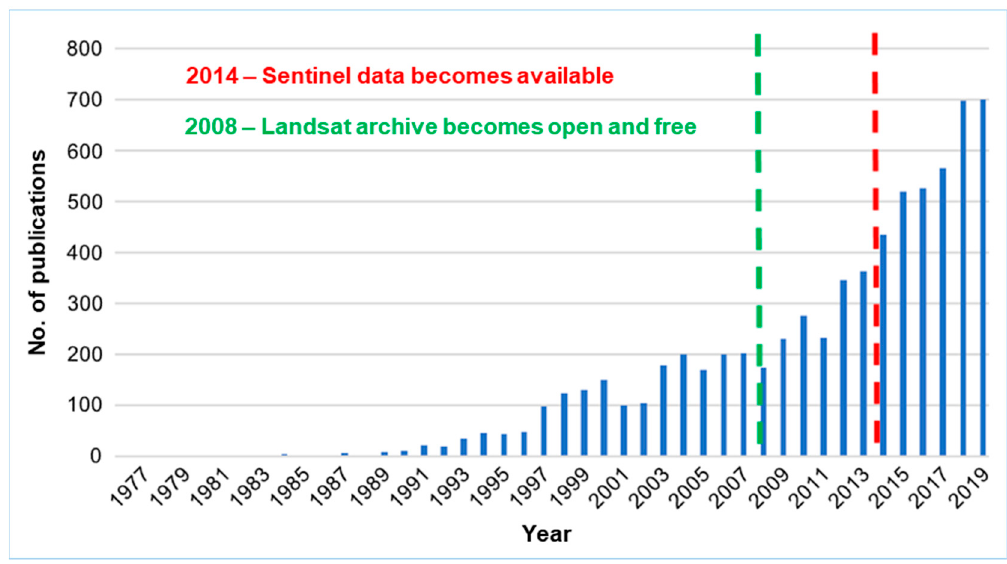
Figure 1. Number of earth observation (EO)-related geohazards publications per year for papers in journals, books, and series. The search was performed through the Web of Science portal based on the following keywords (in quotes) and Boolean Operators (in uppercase): “Earth Observation” OR “Remote Sensing” AND “Geohazards”.